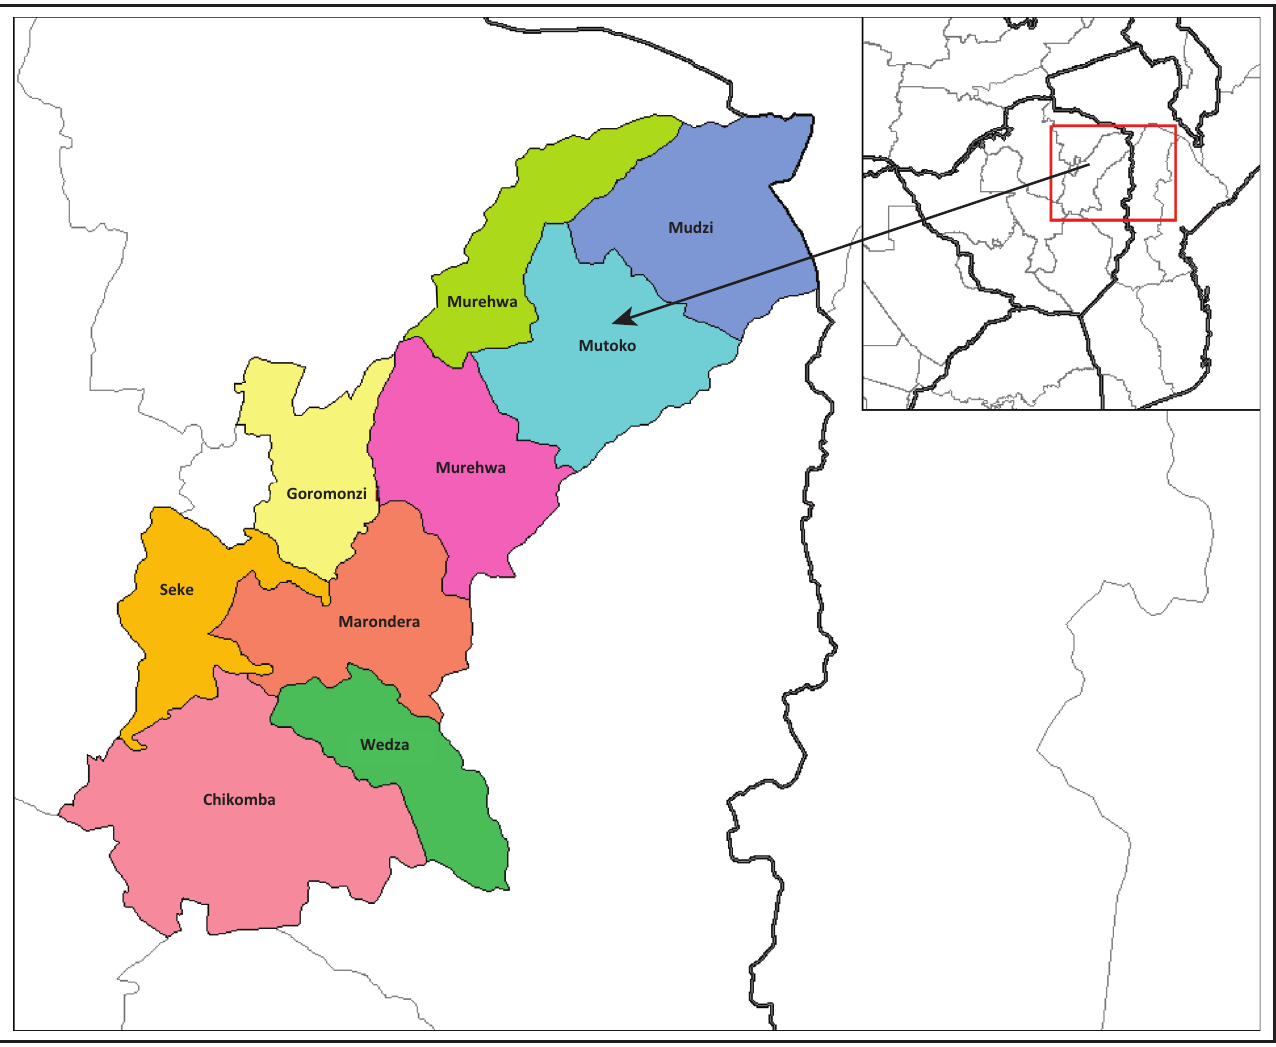
FIGURE 1: Geographical location of Mutoko rural community (towns and provinces of Zimbabwe, Mashonaland East Province, location of Mutoko and the geographical layout of Mutoko).